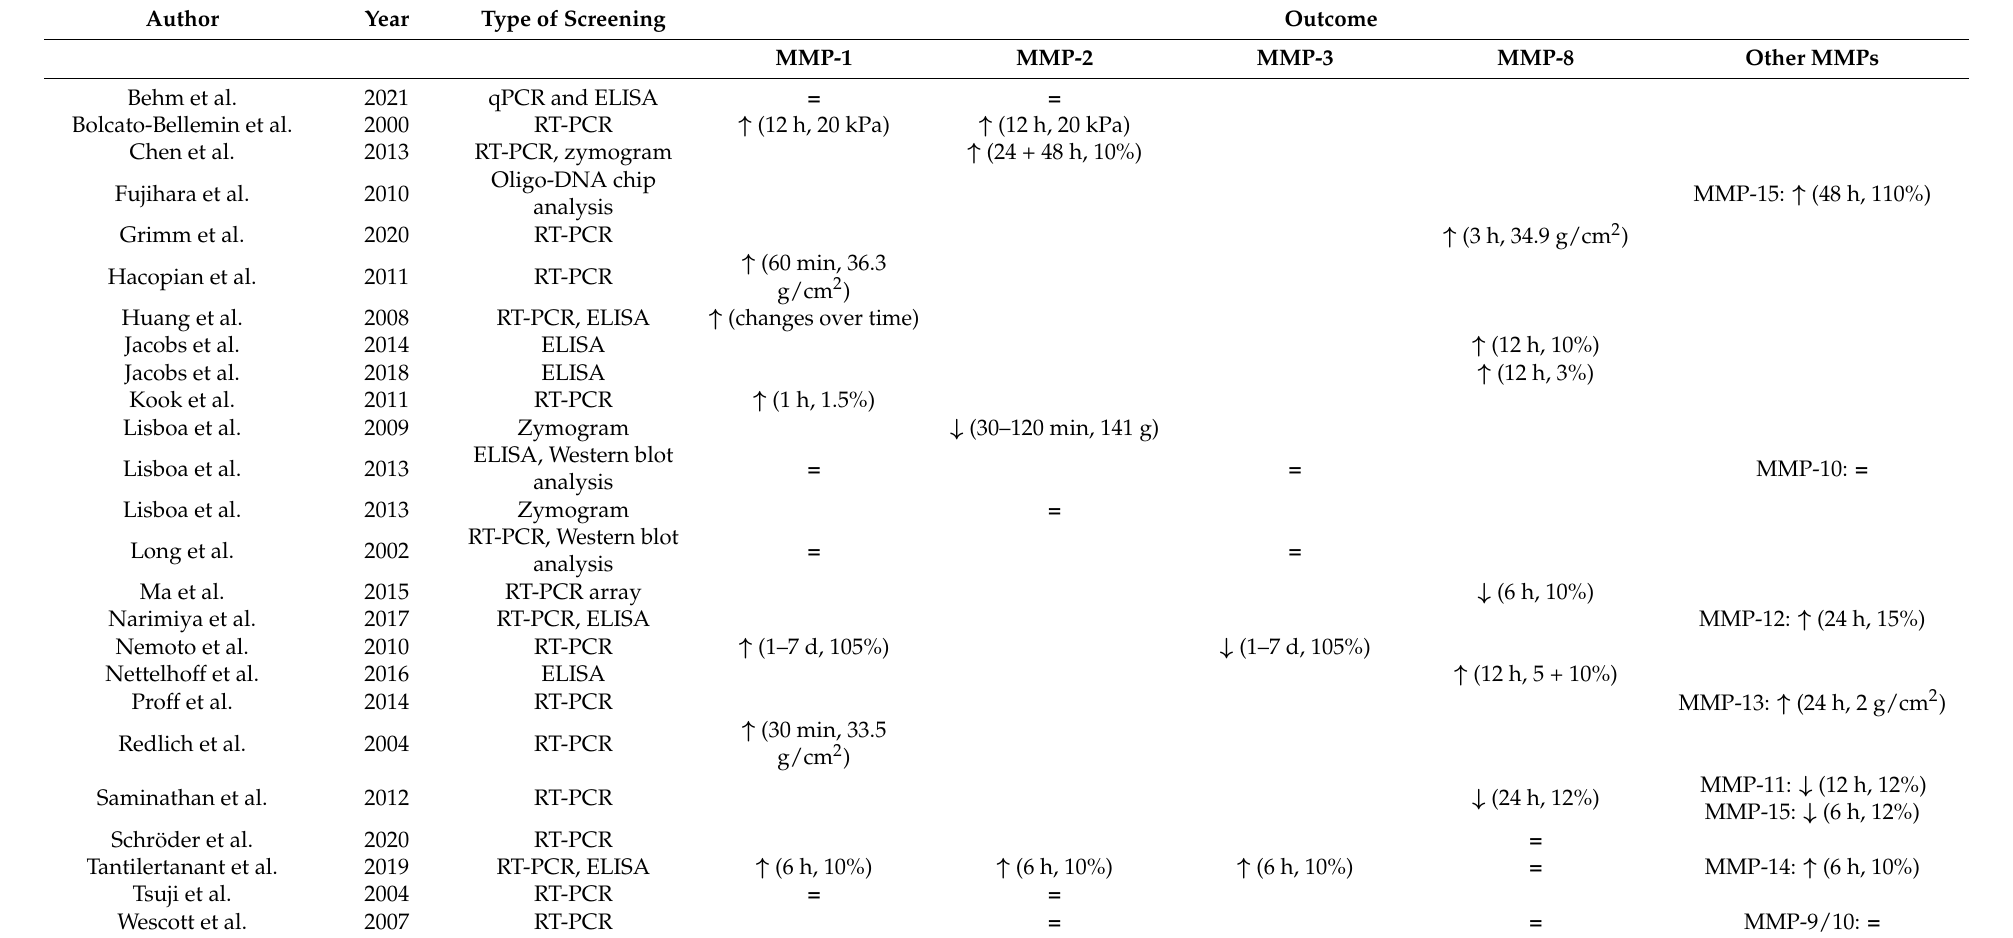
Table 3. MMPs outcome from all included in vitro